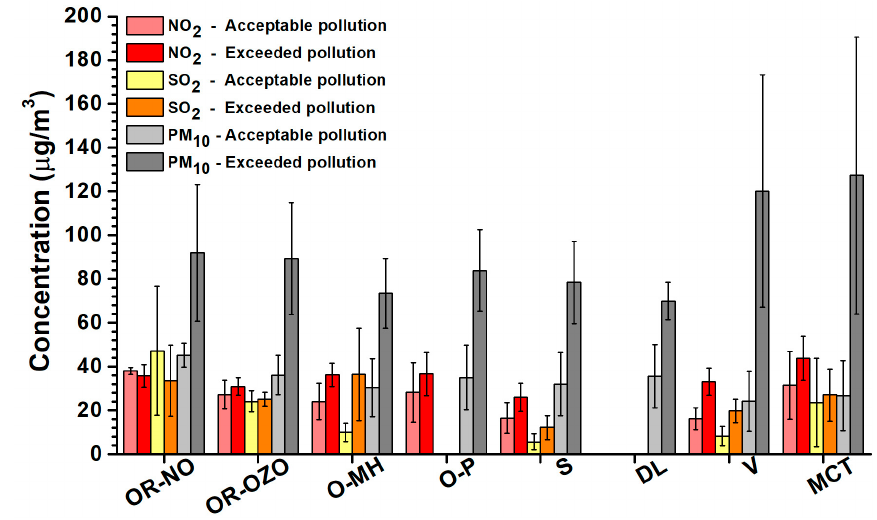
Figure 3. The average concentrations of NO 2 , SO 2 and PM 10 with the standard deviations for 2018. Table 1. The minimal and maximal concentration ranges of all measured values, arithmetical means (AVG), standard deviations (STD) and ratio of average values AP / EP for the period of acceptable (AP) and exceeded pollution